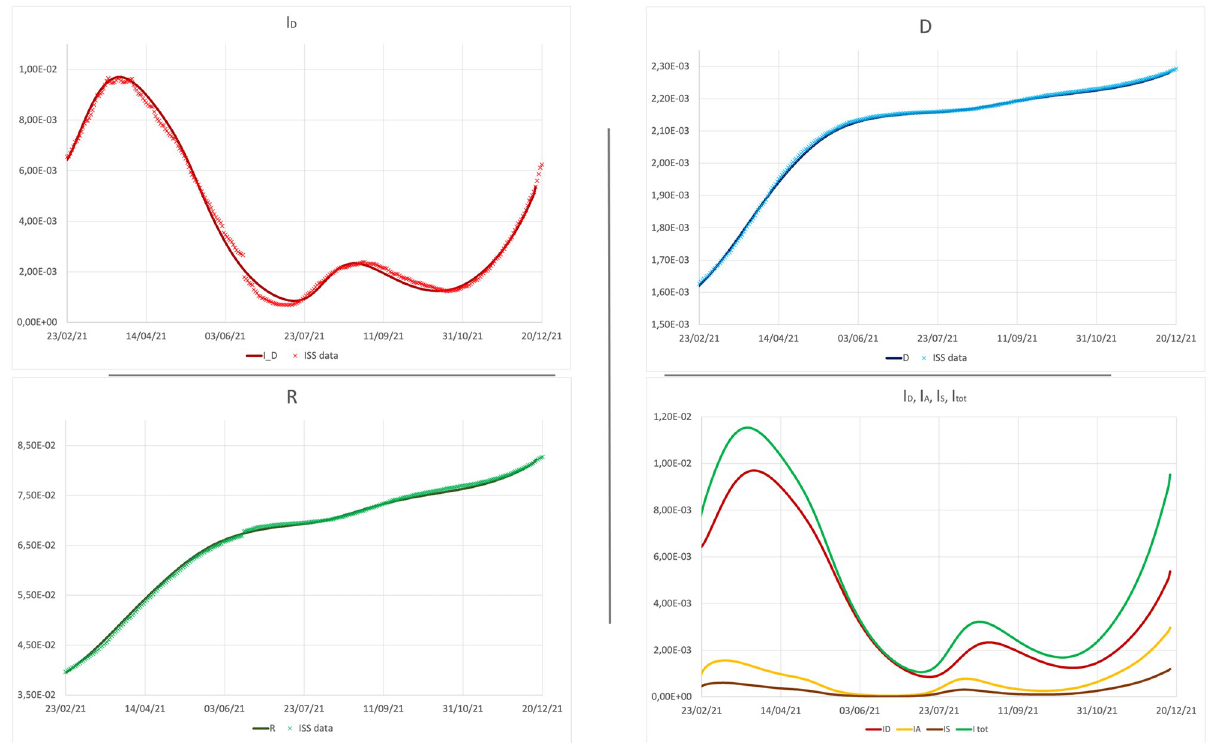
Fig 2. Upper panel —left: active detected cases; right: dead detected cases. Lower panel —left: recovered detected cases; right: detected, asymptomatic, symptomatic and total active cases.